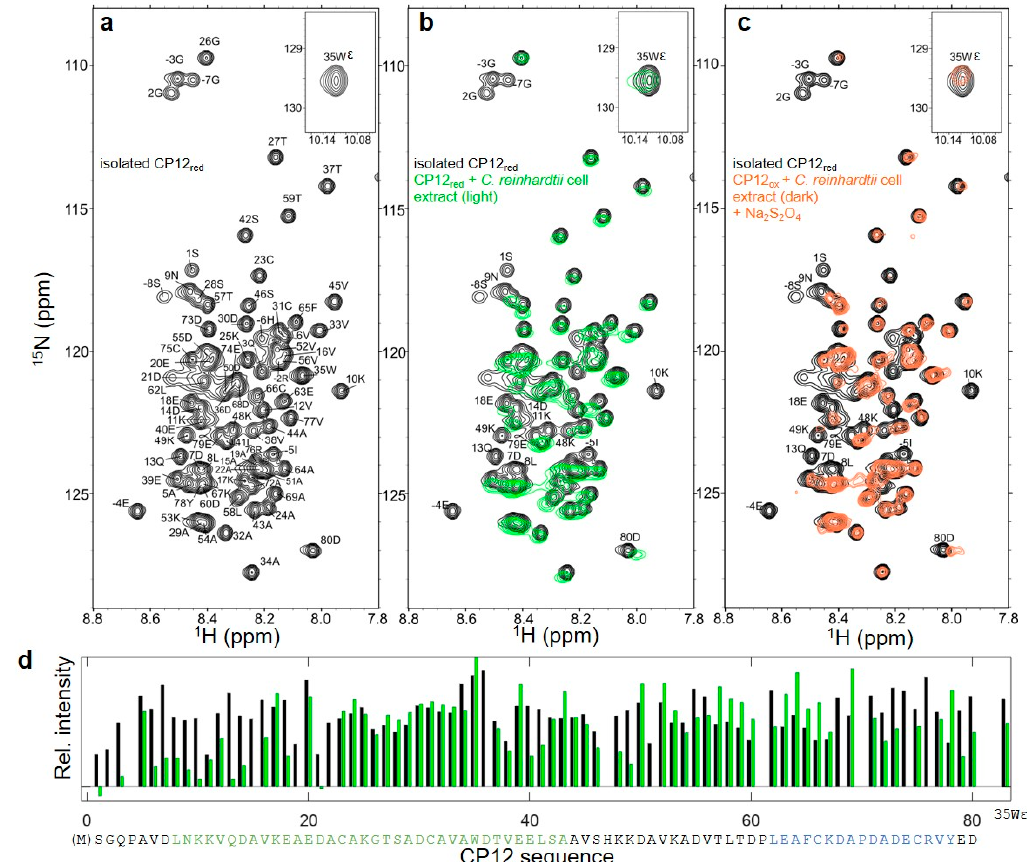
Figure 4. CP12 red in isolation and in the presence of C. reinhardtii cell extract. ( a ) 1 H- 15 N HSQC spectrum of isolated CP12 red . The region of the tryptophan side chain is shown in the insert. ( b ) Overlay of the 1 H- 15 N HSQC spectra of isolated CP12 red (black) and that of CP12 in the presence of C. reinhardtii cell extract (green, molecular crowding corresponding to 15 mg mL − 1 of protein). The data are recorded in the presence of 20 mM DTT red . ( c ) 1 H- 15 N HSQC of CP12 in the presence of C. reinhardtii cell extract collected in the dark (molecular crowding corresponding to 19 mg mL − 1 of protein), 0.1 mM DCMU, and 20 mM dithionite as a strong reducing agent. ( d ) Signal intensities for all residues in the 1 H- 15 N HSQC spectrum of isolated CP12 red (black), and in the 1 H- 15 N HSQC spectrum of CP12 red in the presence of C. reinhardtii cell extract (green). Signal intensities were normalized against the mean of all intensities. The CP12 sequence is indicated below the graph with the same color coding as in Figure 2.